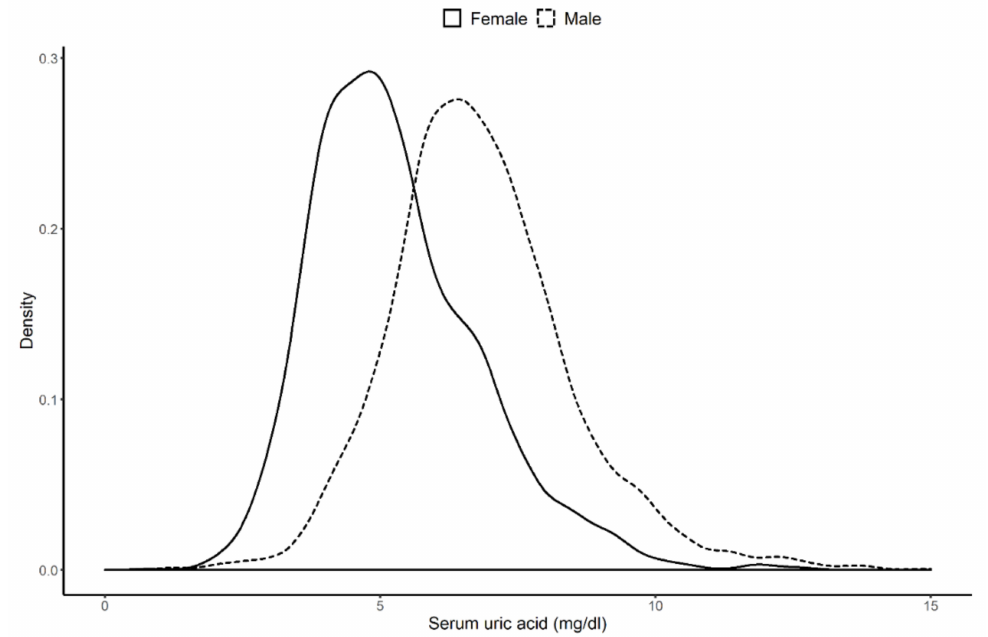
Figure 2. Di ff erence in distribution of serum uric acid by sex. The median of serum uric acid level was 6.7 mg / dl in male and 5.0 mg / dl in